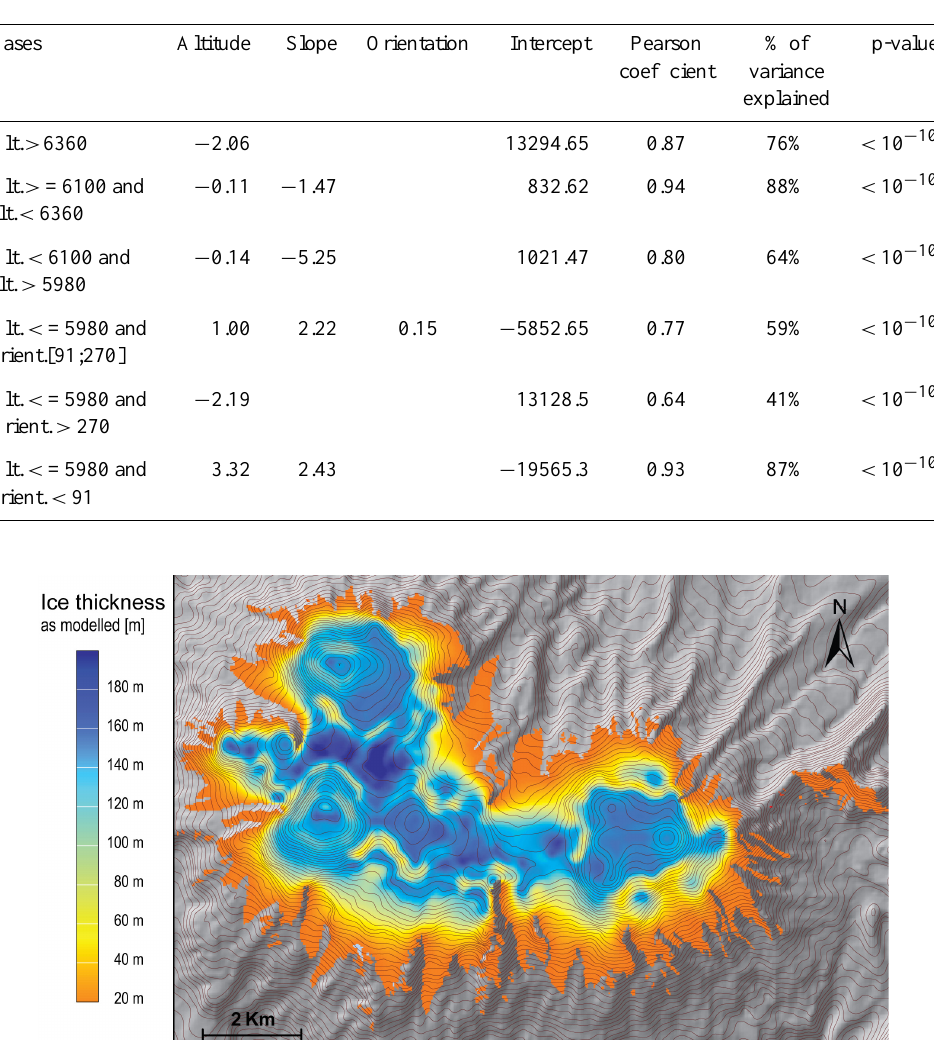
Table 8. Quality of regressions used for modelling ice thickness.